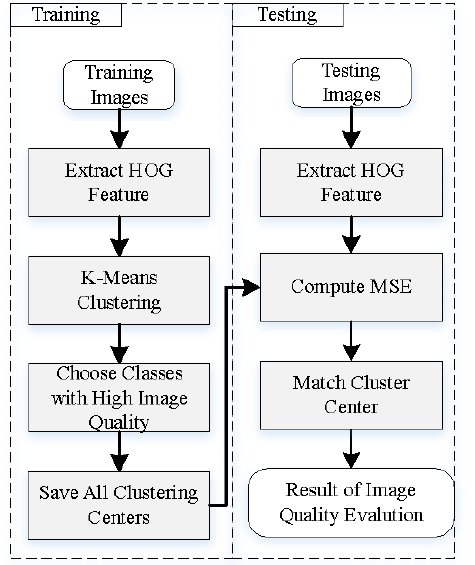
Figure 5. IQE module. In the training part, images are extracted HOG feature and realize self- classification by K-means clustering. Clustering centers with high image quality are picked out. In the testing part, images are told whether they meet the quality requirements by calculating the MSE distance between it and all the clustering